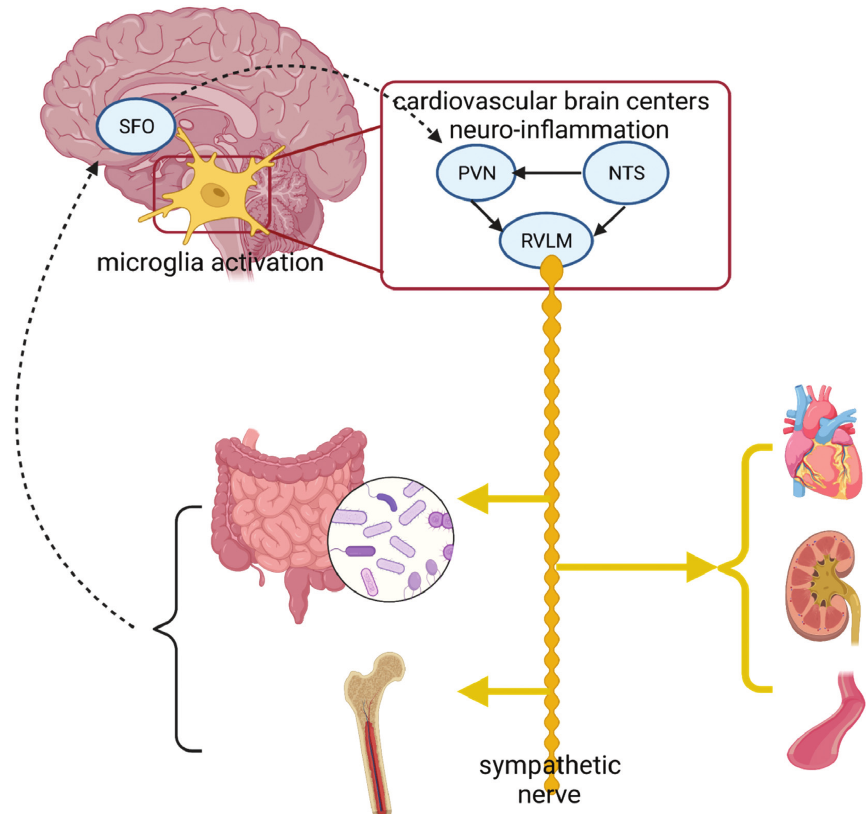
Figure 1: The hypothetic mechanisms of neuroinflammation-mediated bidirectional communication in the microbiota-gut-brain